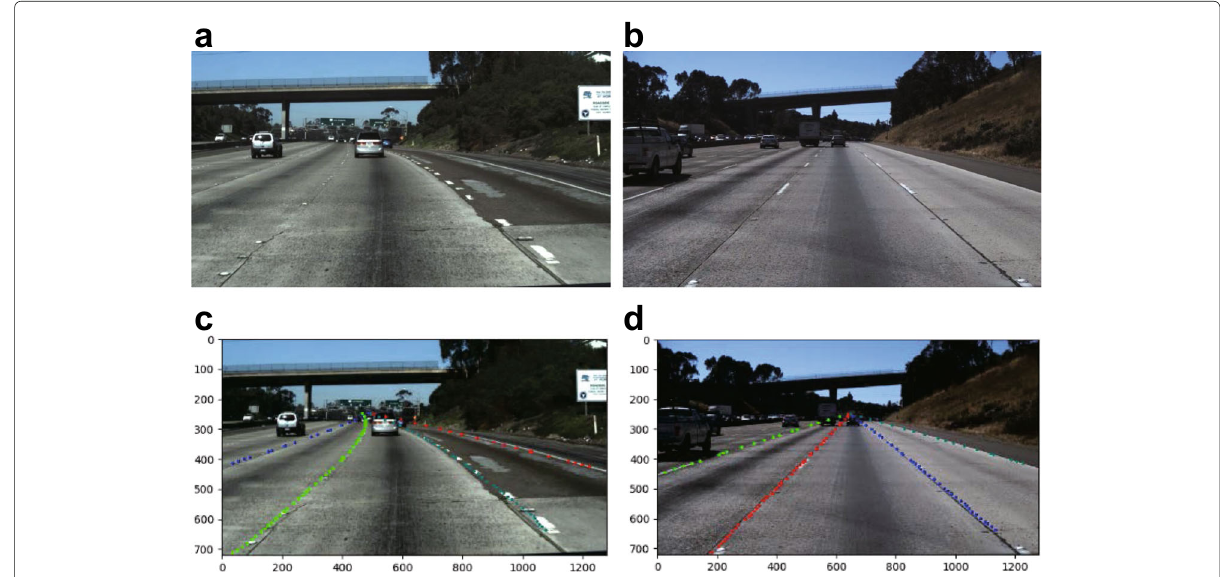
Fig. 4 Lane line detection under lane line edge